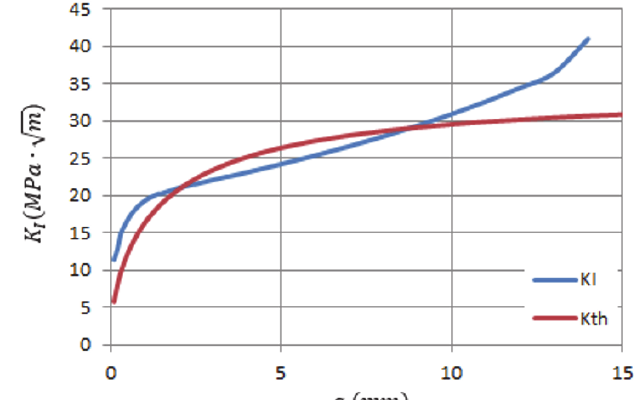
Figure 5: Curves K I (a)  a and K EACth (a)  a generated by the analysis of the linear elastic DC(T) under EAC and P  6750N.